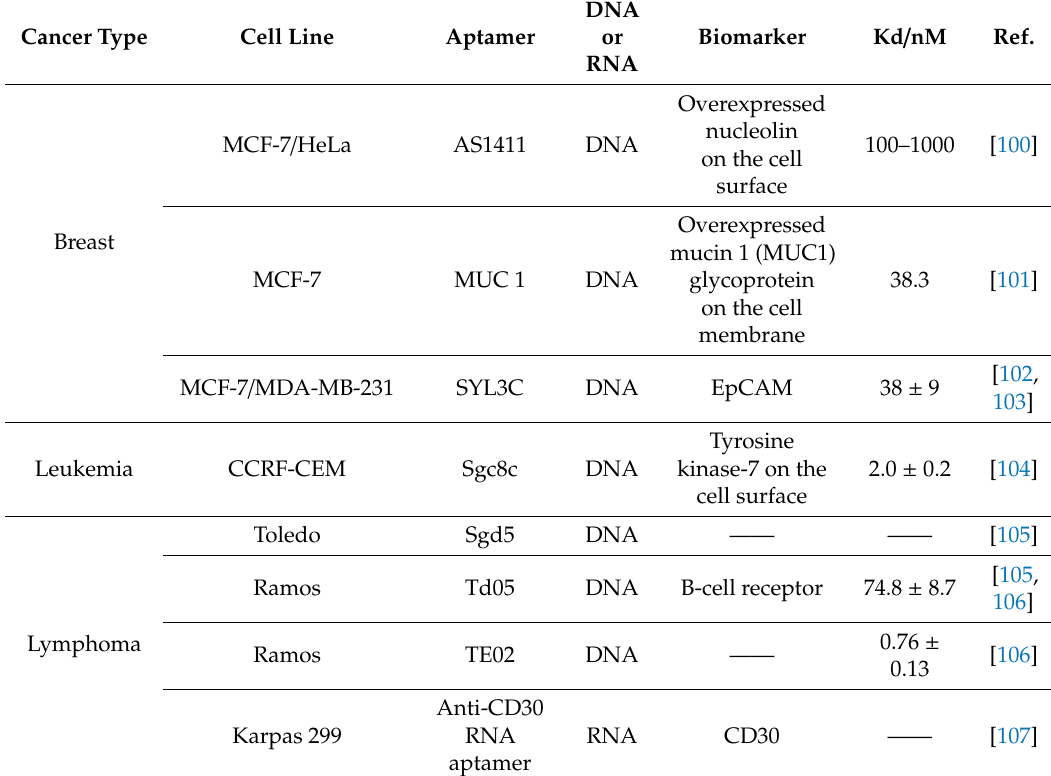
Table 2. Summary of aptamers used for CTC